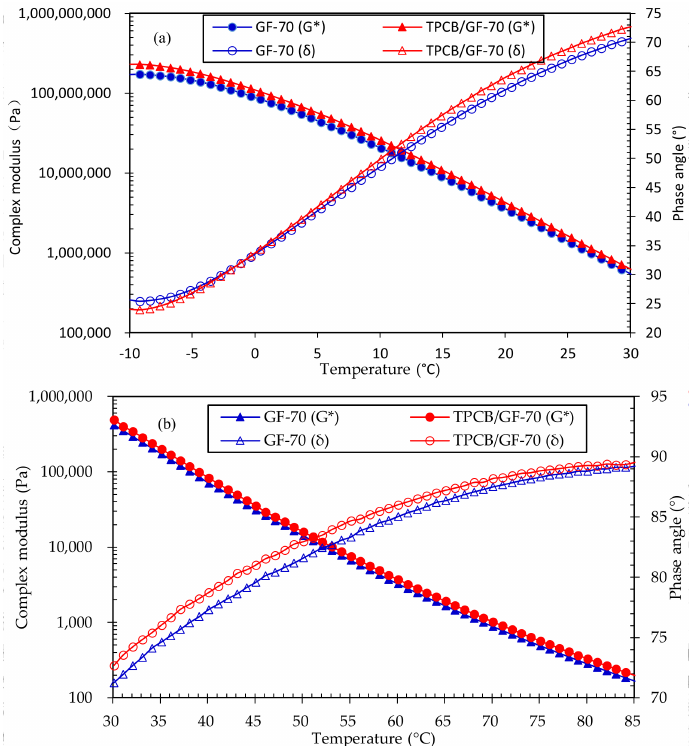
Figure 5. G* and δ of GF-70 and TPCB/GF-70 in the temperature range of − 10~30 ◦ C ( a ) and 30~85 ◦ C ( b